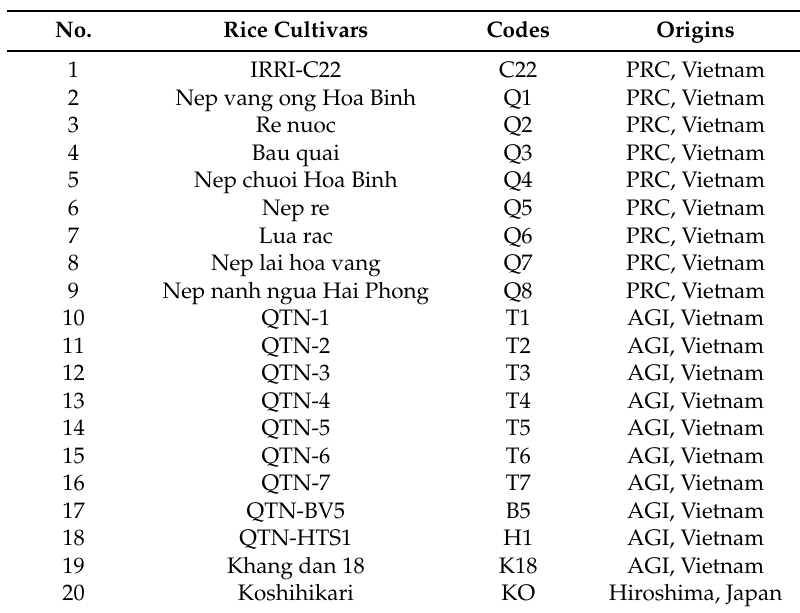
Table 1. Rice cultivars and their origins.